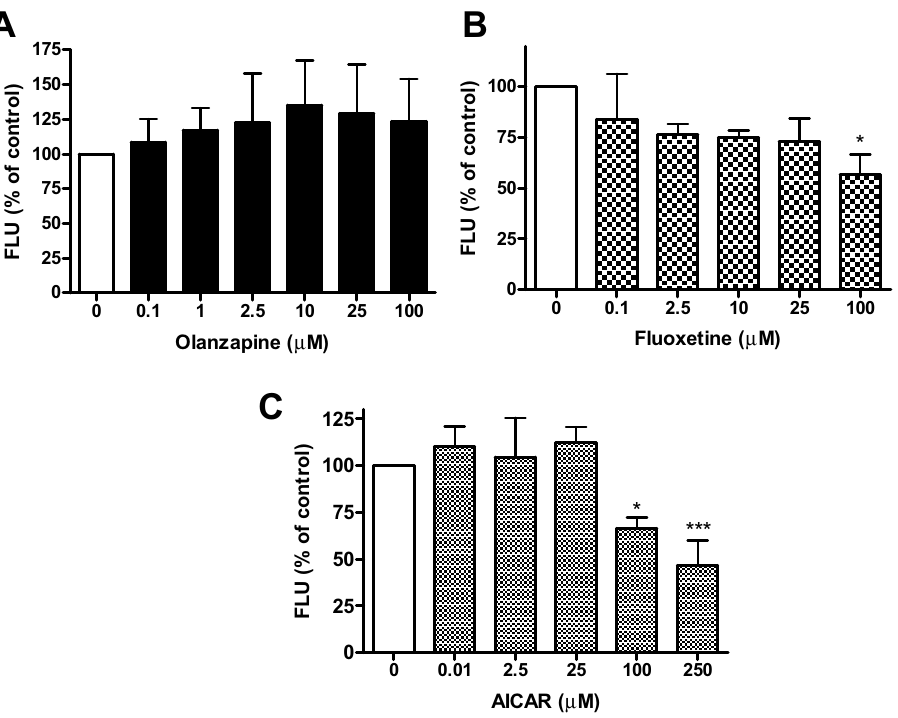
Figure 4. Effects of drugs on Nile red fluorescence of SS104 C. elegans . Bar charts represent the mean Nile red fluorescence of three independent experiments (± SD). Worms were treated with different concentrations of ( A ) olanzapine, ( B ) fluoxetine, and ( C ) AICAR normalized to vehicle treated control worms. Statistical significance assessed by one way ANOVA and Bonferroni post-test (* p < 0.05, *** p <